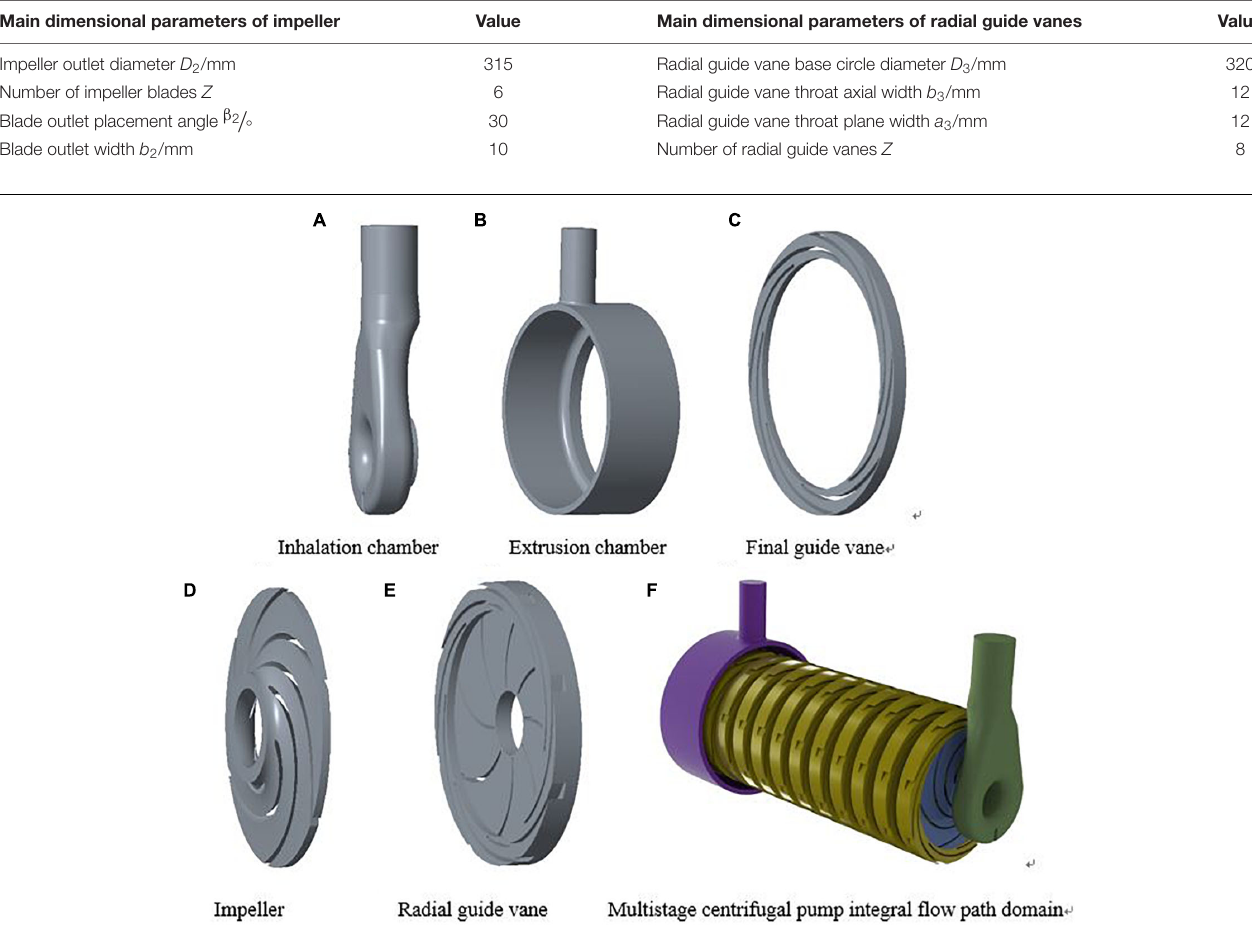
FIGURE 1 | Fluid domain model of multistage centrifugal pump. (A) Inhalation chamber, (B) Extrusion chamber, (C) Final guide vane, (D) Impeller, (E) Radial guide vane, (F) Multistage centrifugal pump integral flow path